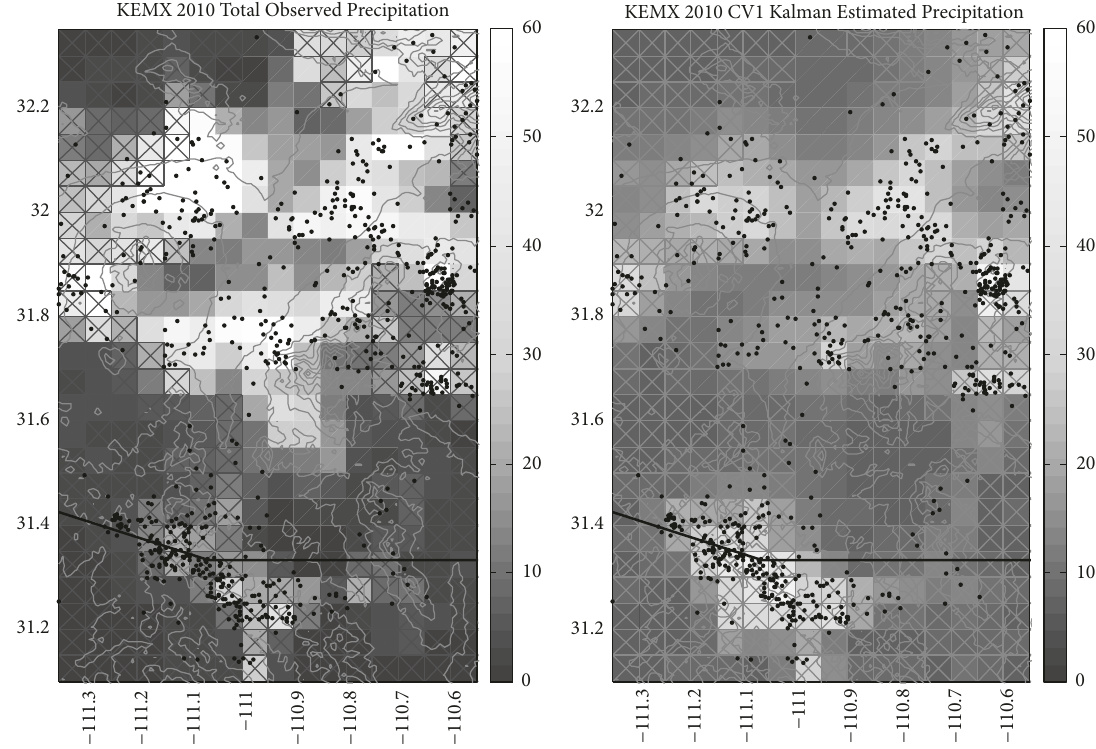
Figure 3: Precipitation map for a Mesoscale Convective System in southern Arizona. Dots are lightning strikes; grids with crosses do not have precipitation sensor coverage, from